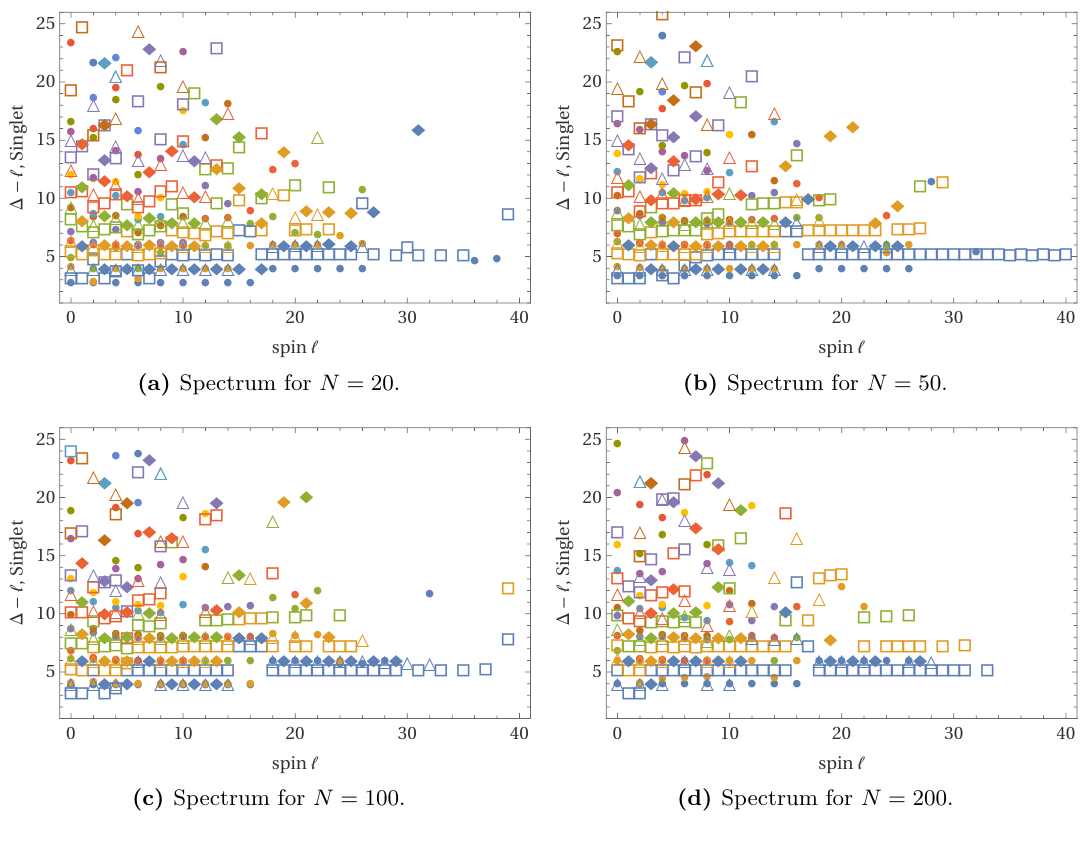
(c) Spectrum for N = 100 . (d) Spectrum for N = 200 . Figure 12. Zeros of the functionals at the boundary of the twist gap exclusion plot in figure 4. The values of N shown are, from the top left to the bottom right, N = 20 , 50 , 100 , 200 . We used the bound obtained with Λ = 27 . The different markers are used to indicate the representation exchanged. They are defined as follows → Singlet